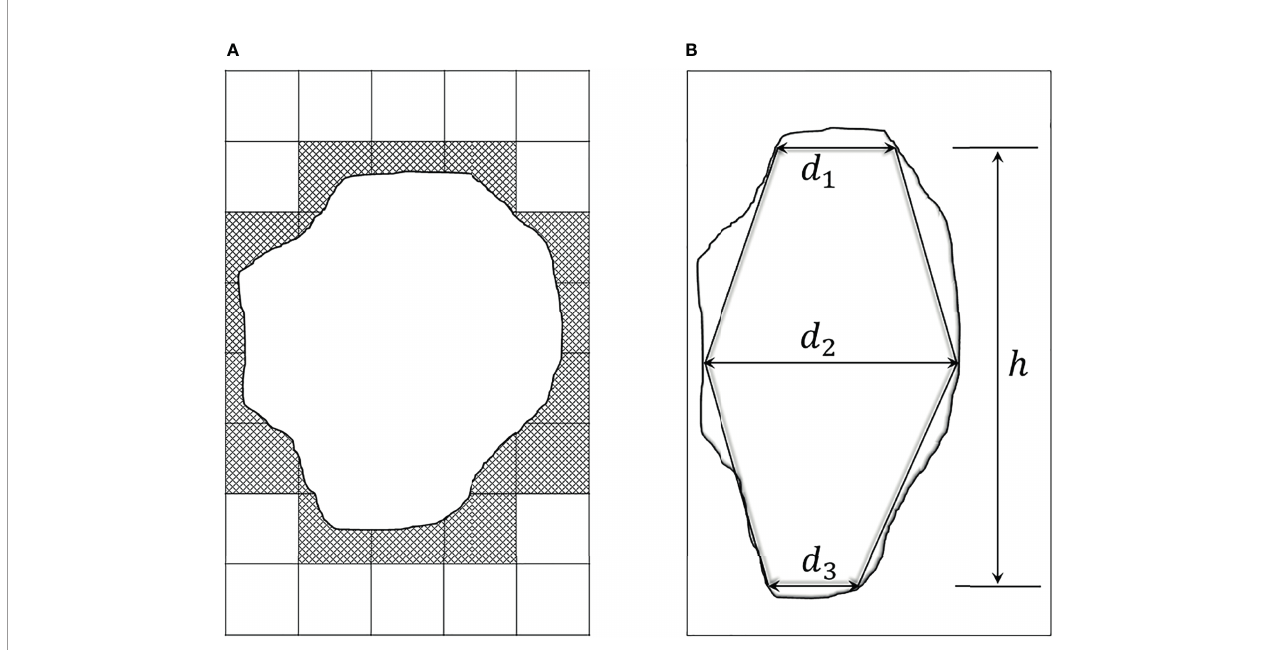
FIGURE 1 | Two existing methods for GTV estimation. (A) A cross-section view of the voxel volume summation method. The middle white part denotes the lesion mask, and the surrounding dash area denotes the extra computation. (B) Two opposed truncated cones summation method, d 1 and d 3 respectively represent the cranial and caudal transverse diameters of the tumor. d 2 is the maximal transverse diameter, and h is the tumor